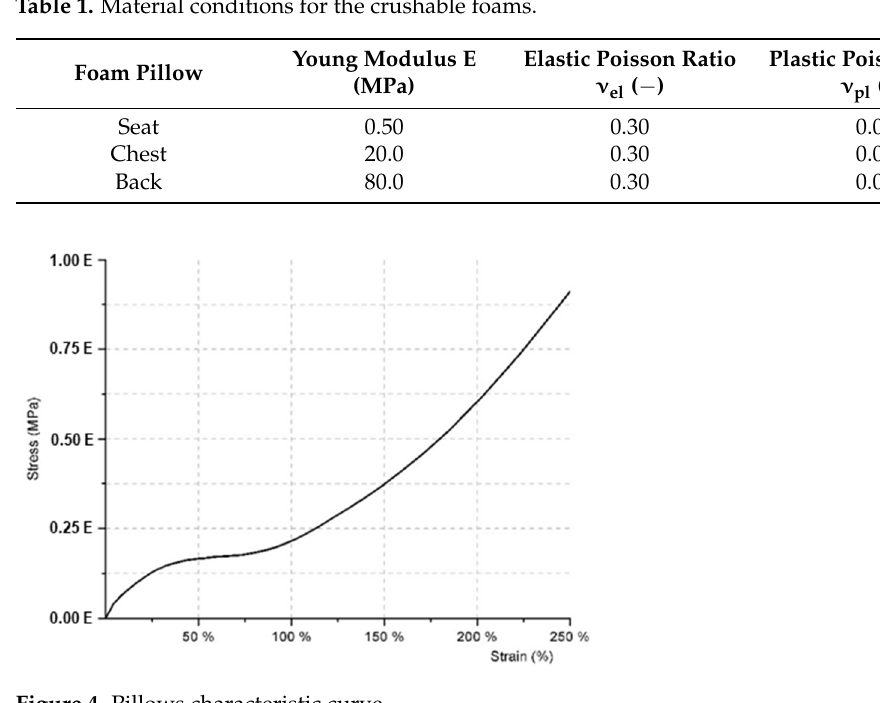
Table 1. Material conditions for the crushable foams.